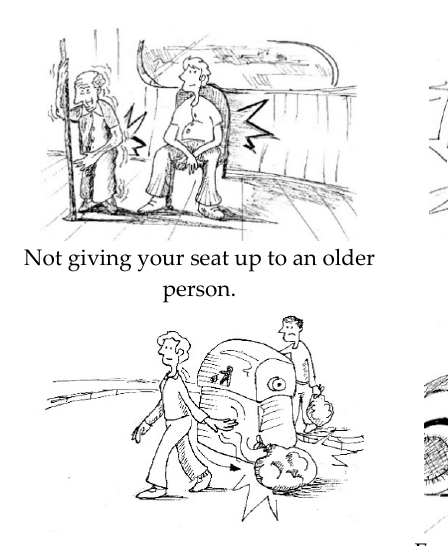
Figure A1. Civic pictures.